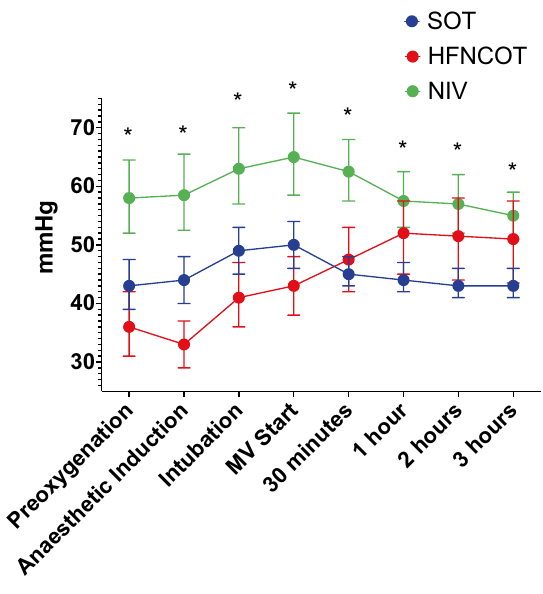
Fig. 1 Repeated measures of transcutaneous PCO 2 (PtcCO 2 ) before and after the beginning of the mechanical ventilation (MV) according to